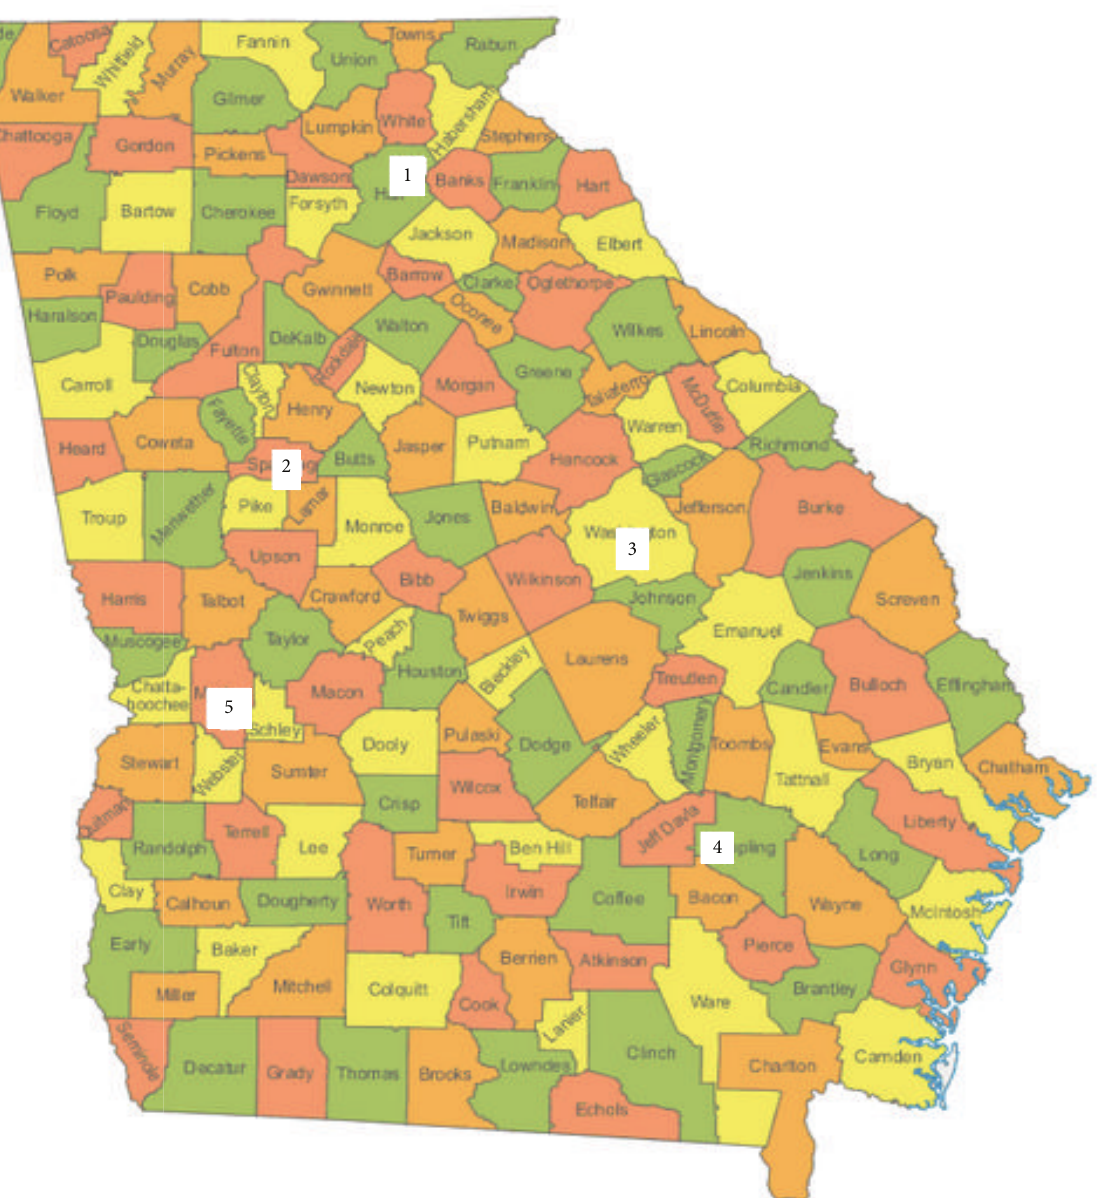
Figure 3: The geographic locations for the hospital network in Georgia in the United States, problem set